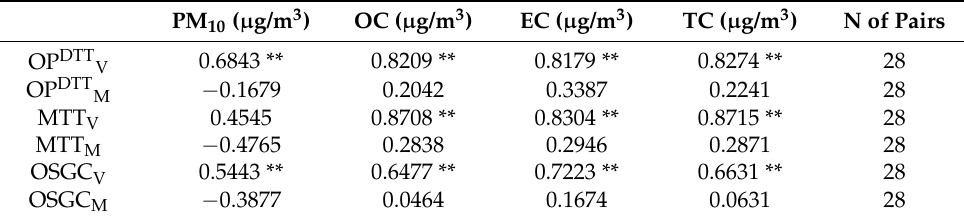
Table 2. Pearson’s correlation coefficients between toxicological indicators and PM 10 concentrations and carbon content. OP DTT V and OP DTT M represent the OP value referred to the inhaled air or the sampled PM 10 mass, respectively. MTT V and MTT M correspond to the cell mortality value assessed by the MTT test and referred to the sampled air volume or the sampled PM 10 mass, respectively. N = numbers of pairs. ** indicates cases with p <